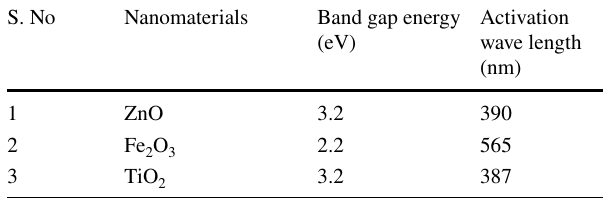
Table 2 The band gaps and wavelength of activation for some photo-